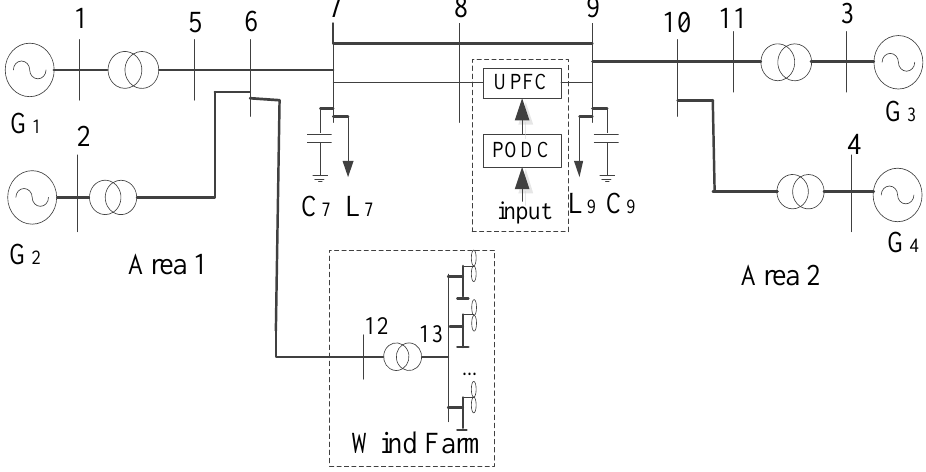
Figure 3. The two-area four-machine interconnected power system. Table 1. DFIG data.